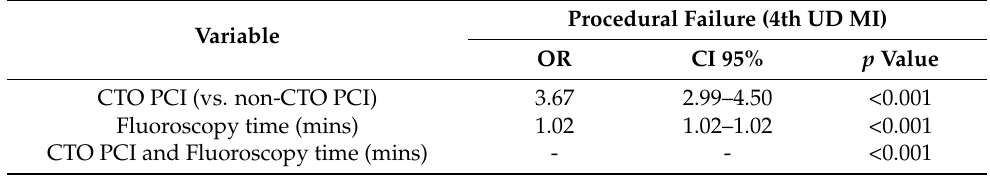
Table 4. Primary logistic regression analysis between chronic occlusive (CTO) percutaneous coronary intervention (PCI), fluoroscopy time (both as independent variables), and procedural failure (as dependent variable) by applying the fourth Universal Definition (UD) of myocardial infarction (MI).